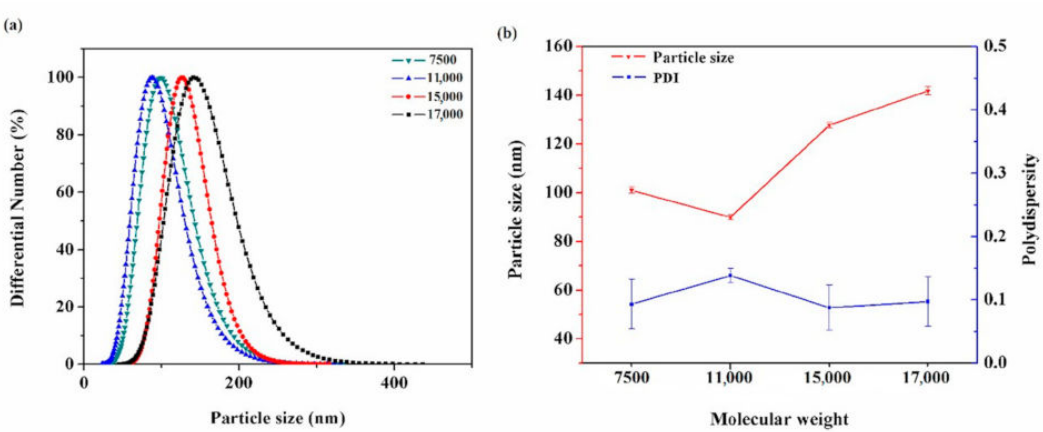
Figure 7. PSD of sizing agent emulsions with the four di ff erent molecular weights: ( a ) PSD test results of emulsions, ( b ) the change of particle size and PDI with molecular